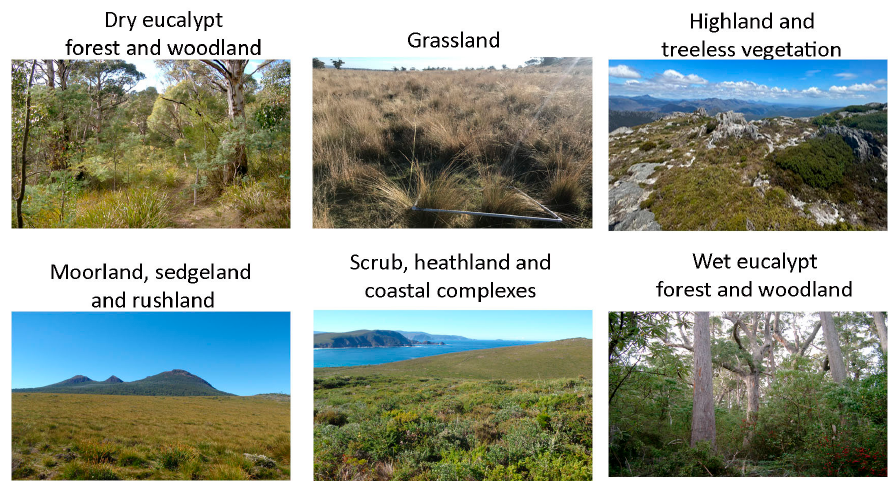
Figure 2. Images of the six dominant vegetation types in Tasmania. Photographs: top left—Jamie Kirkpatrick, top middle—David Heaton, top right—Melinda McHenry, bottom row—Jamie Kirkpatrick. Native and Introduced Vertebrate Herbivores of Tasmania